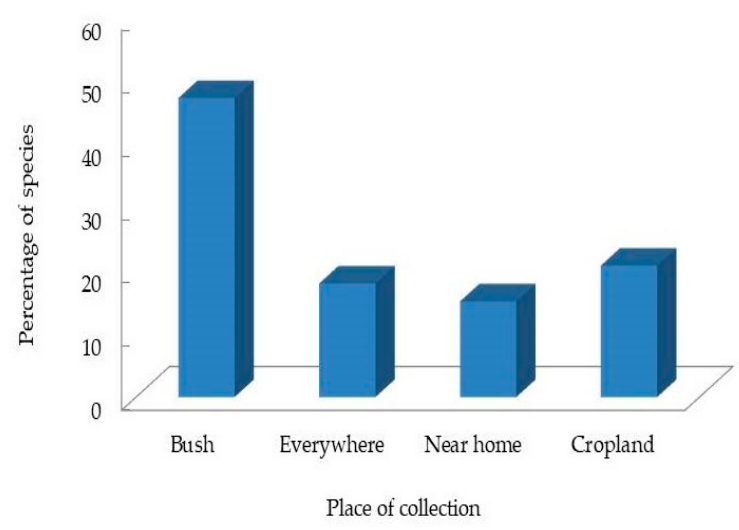
Figure 3. Places of collection of medicinal plants cited in this study.